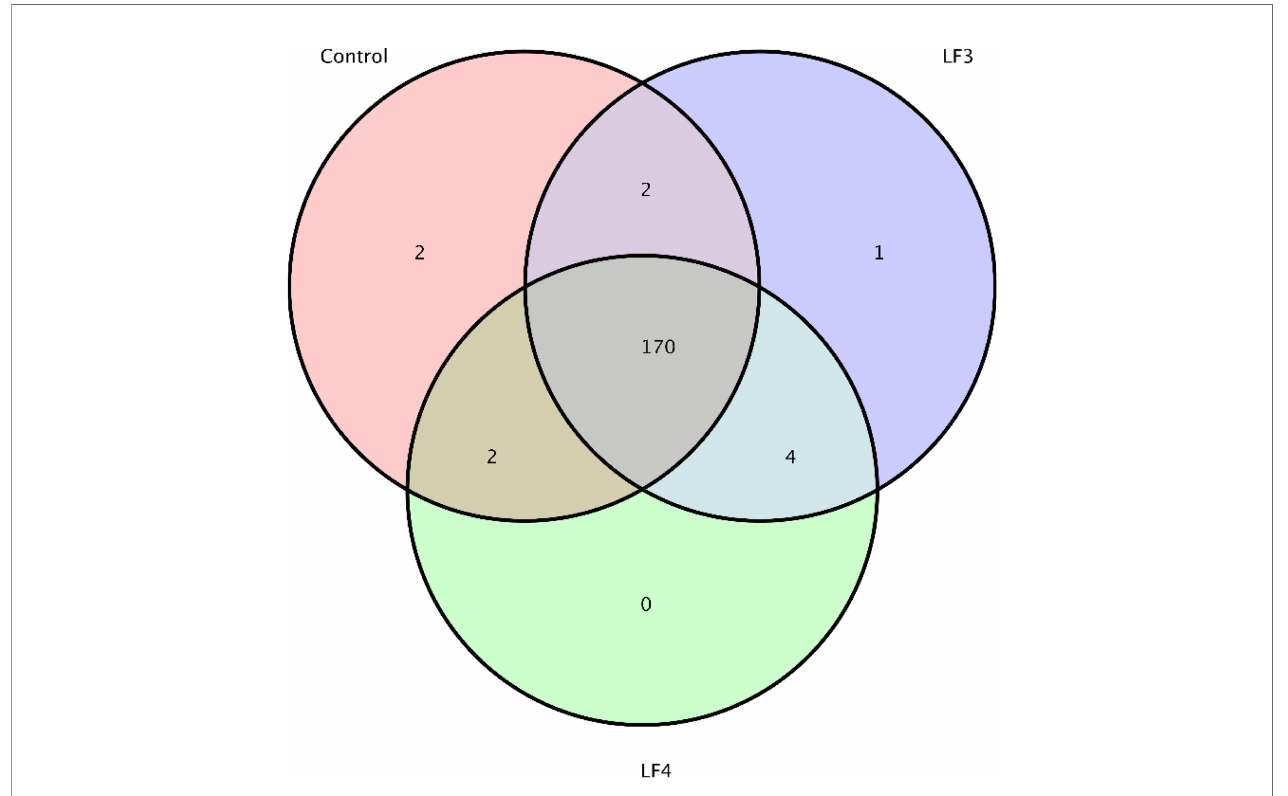
FIGURE 1 | Venn diagram of unique and shared OTUs between the three